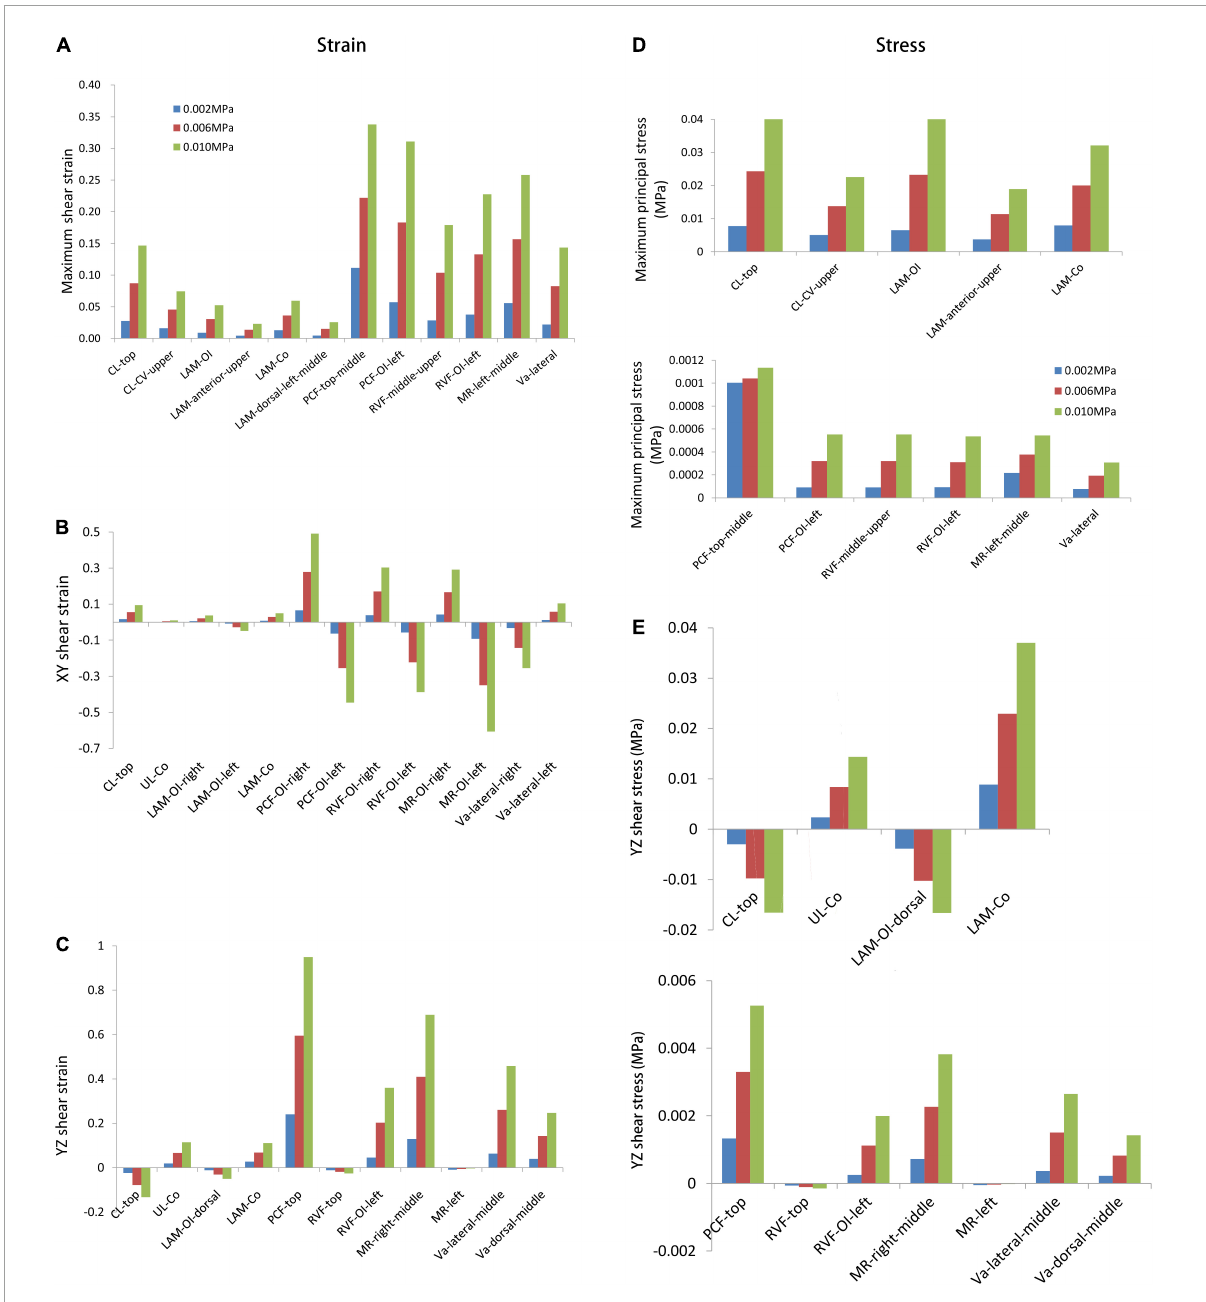
FIGURE4 The maximum stress and strain values with intra-abdominal pressures ranging from 0.002 MPa to 0.01 MPa for the designated supporting tissues. The comparisons were shown for the (A) maximum shear strain; (B) XY shear strain; (C) YZ shear strain; (D) maximum principal stress; (E) YZ shear stress. CL, cardinal ligaments; CL-CV, cardinal ligaments-cervical junction; LAM, levator ani muscle; LAM-OI, levator ani muscle-obturator internus junction; LAM-Co, levator ani muscle-coccygeus junction; PCF, pubocervical fascia; PCF-OI, pubocervical fascia-obturator internus junction; RVF, rectovaginal fascia; RVF-OI, rectovaginal fascia-obturator internus junction; MR, mesorectum; MR-OI, mesorectum-obturator internus junction; UL-Co, uterosacral ligaments-coccygeus junction; Va,